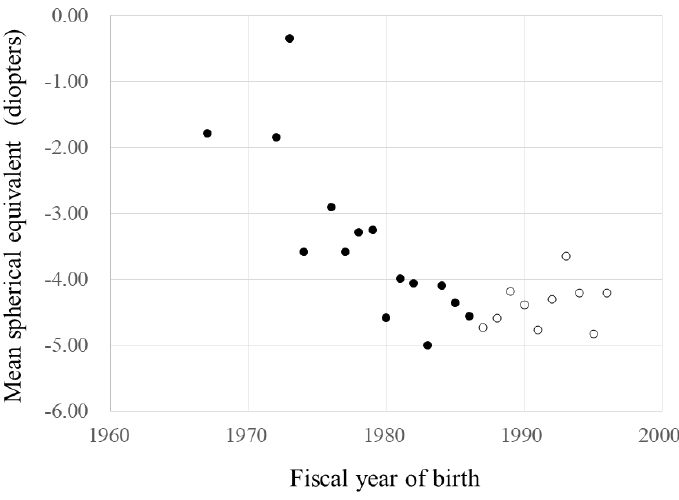
Figure 3. The fiscal year (FY) of birth and mean spherical equivalent. ● , data during the FYs of birth before 1987. ○ , data during the FYs of birth of 1987 and after. During the FYs of birth before 1987, y = 310.0 − 0.158x, r = 0.213, p = 0·004. During the FYs of birth of 1987 and after, p =0.441. The regression of spherical equivalent by FYs of birth before 1987 and after, p = 0.004 (analysis of covariance (ANCOVA)).